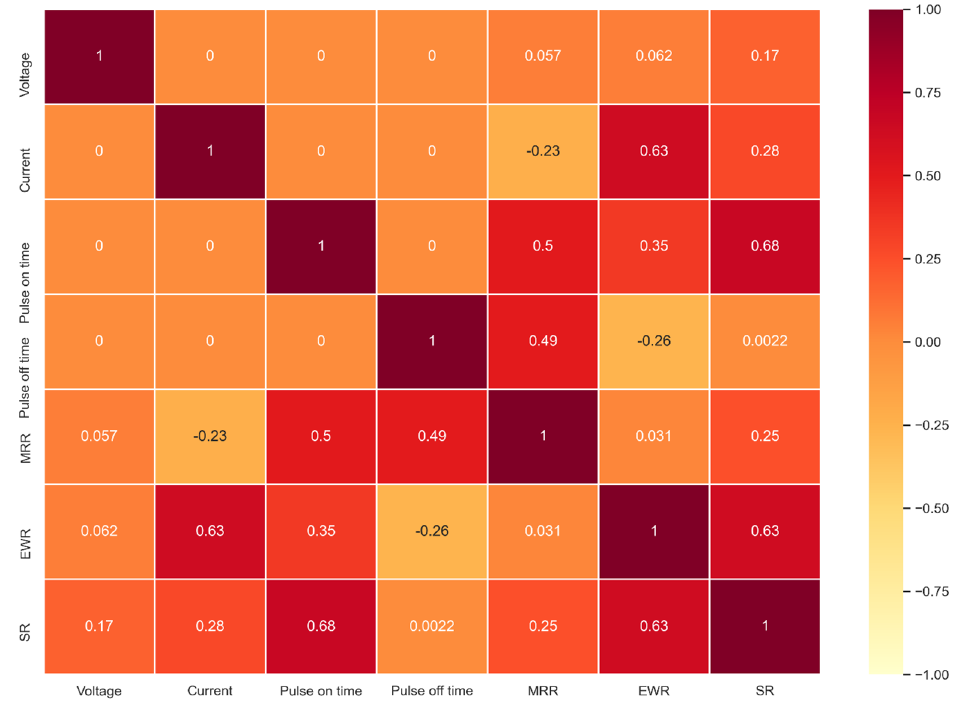
Figure 1. Correlation heatmap between the process parameters and the responses.